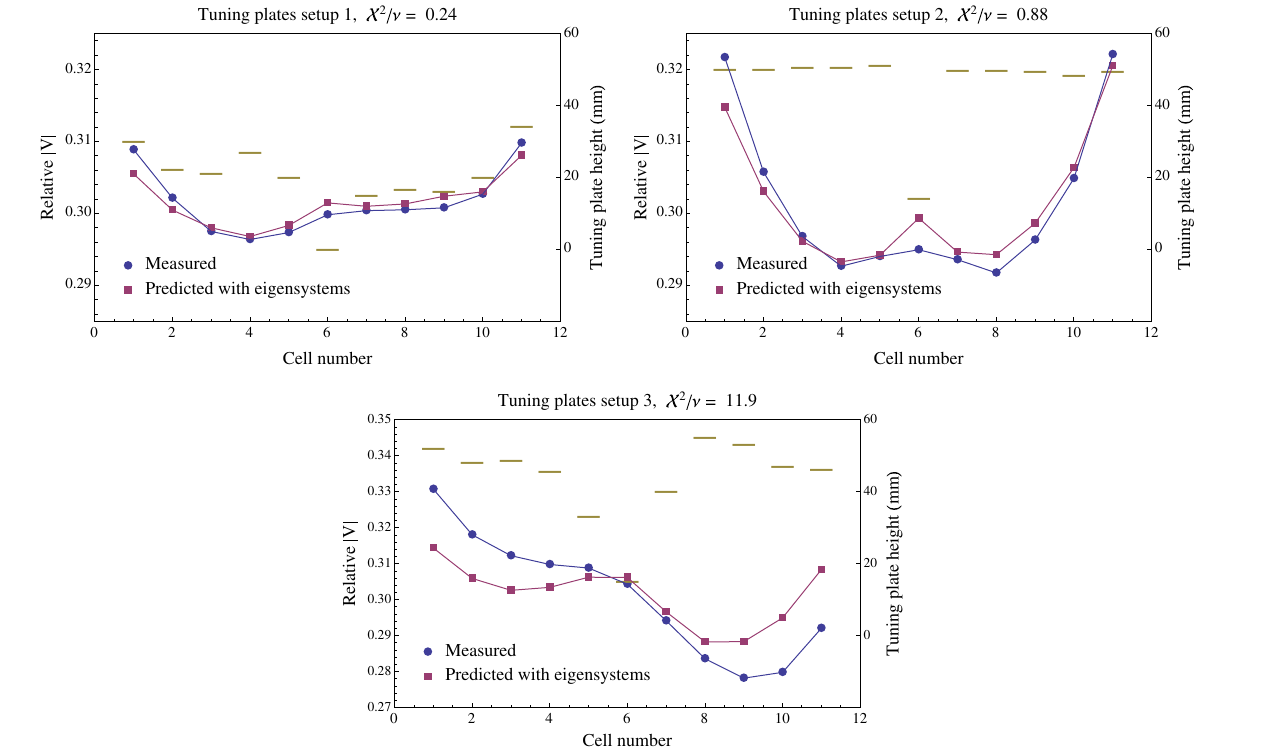
FIG. 15 (color online). The comparison between our model predictions and measurements for three different tuning plates setups are shown here. The – in these graphs shows the tuning plate heights. Because χ 2 = ν < χ 2 = ν the measurements. But χ 2 = ν ≫ 1 in setup 3 and the model prediction is unacceptable although the shape of the profile does mimic the